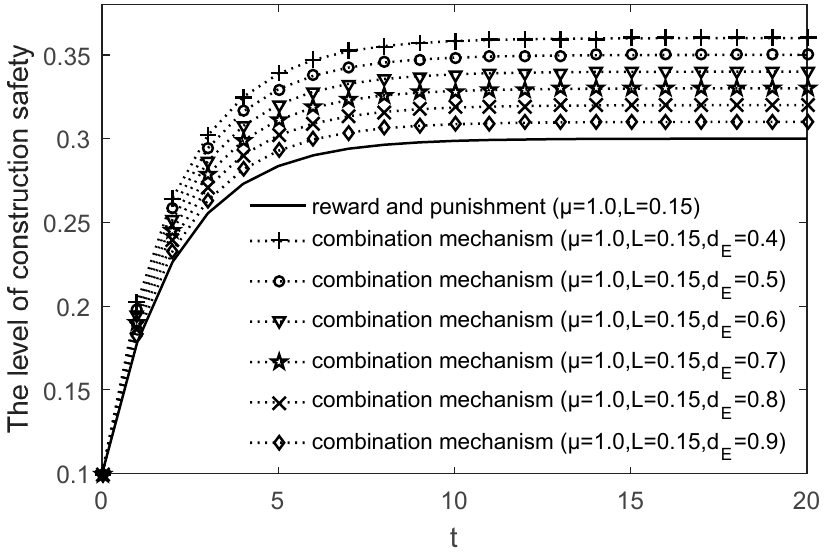
Figure 6. The level of construction safety under the combination mechanism when d E takes different values.